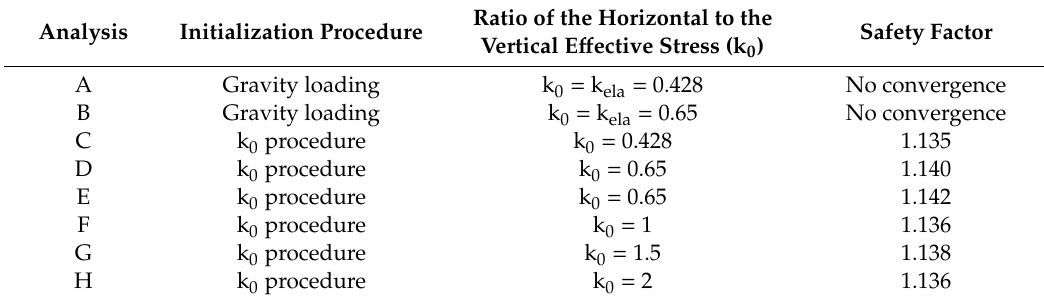
Table 3. Factor of safety obtained through the “c, ϕ reduction”